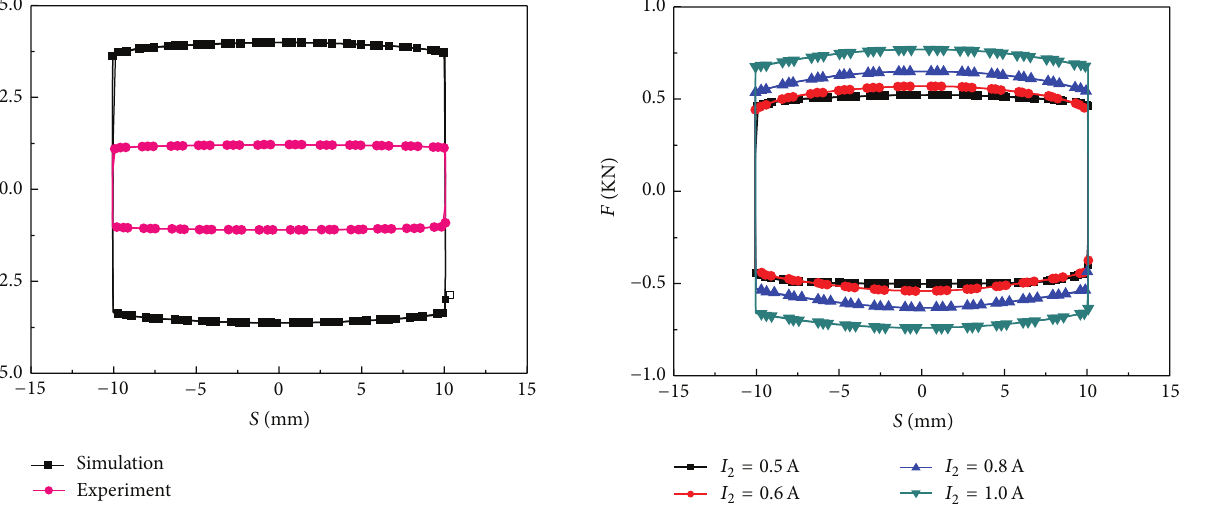
Figure 20: Damping force under different currents in the double coil ( 𝐼 1 = 0.5 A).